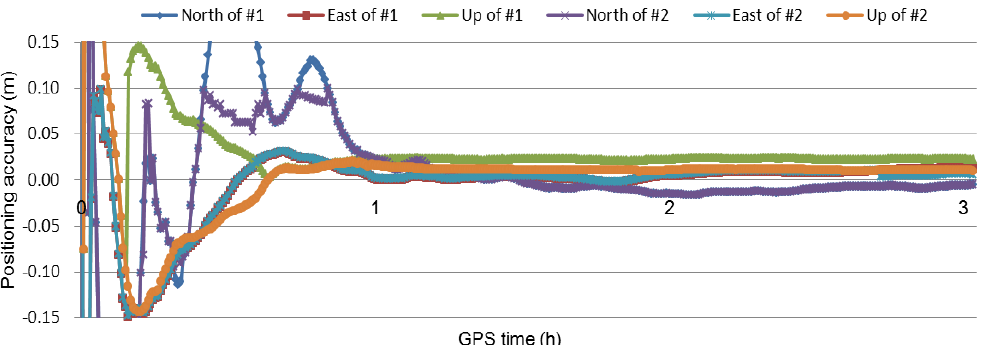
10 of 14 Table 3. Relative positioning accuracy of two method s. Station